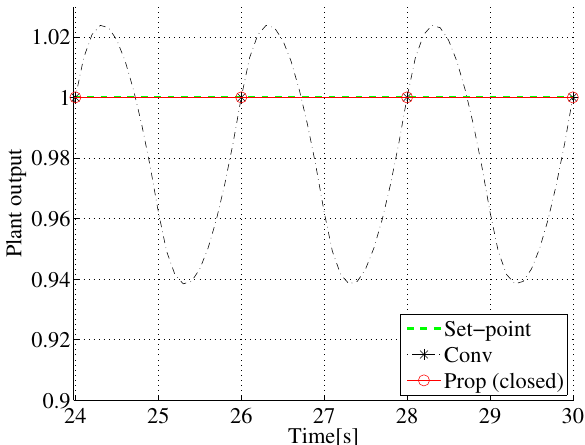
Figure 9. Steady-state trajectories for data in Figure 8.